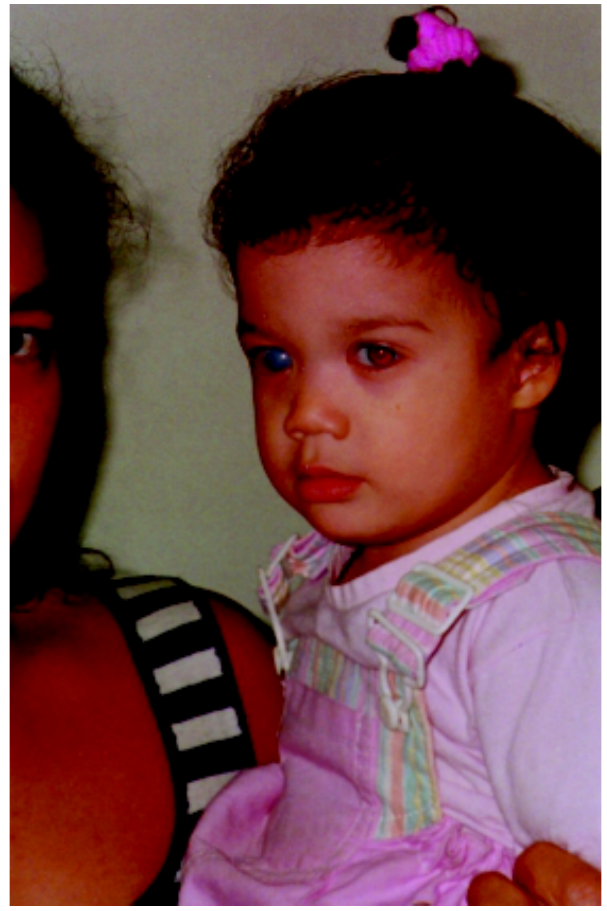
Figure 1 - Proband at 2 years of age. Note left aniridia and right corneal opacity without facial dysmorphies.